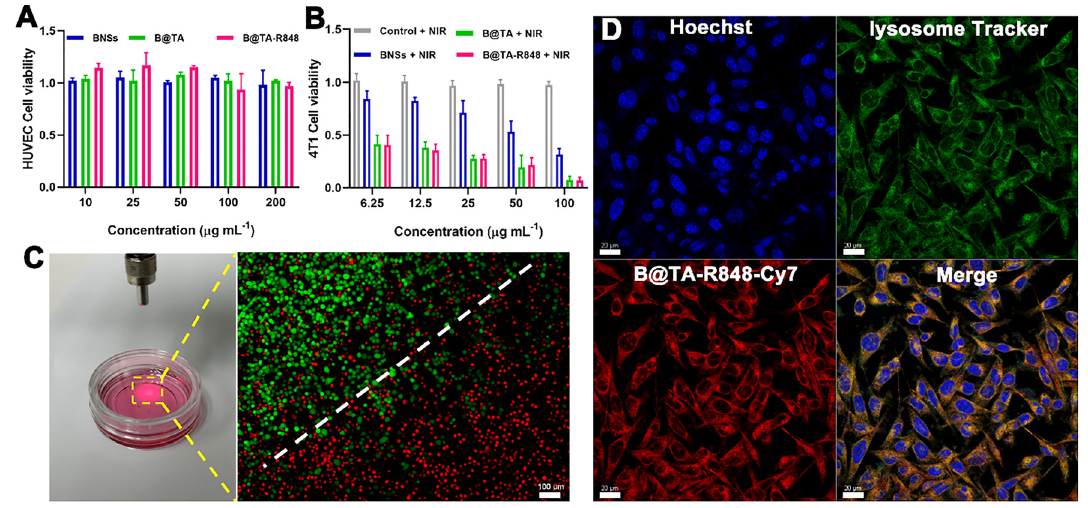
Figure 3: In vitro experiments. (A)RelativeviabilityofHUVECcellsafterincubationwithBNSs,B@TA,andB@TA-R848(concentrationsof10,25,50,100,and200 μ gmL − 1 )for 24h.(B)Relativeviabilityof4T1cellsafterincubationwithBNSs,B@TA,andB@TA-R848(concentrationsof6.25,12.5,25,50,and100 μ gmL − 1 ) for 4 h after irradiation with 808 nm laser (2 W cm − 2 ) for 5 min. (C) Corresponding laser scanningconfocal microscopyof 4T1 cells stained with calcein AM (live cells, green fl uorescence) and PI (dead cells, red fl uorescence), scale bar: 100 μ m. (D) Confocal images of 4T1 cell internalization of B@TA-R848-Cy7 (blue: Cell nucleus stained with hoechst33342; green: Lysosome stained with lysosome tracker; red: B@TA-R848-Cy7), scale bar: 20 μ